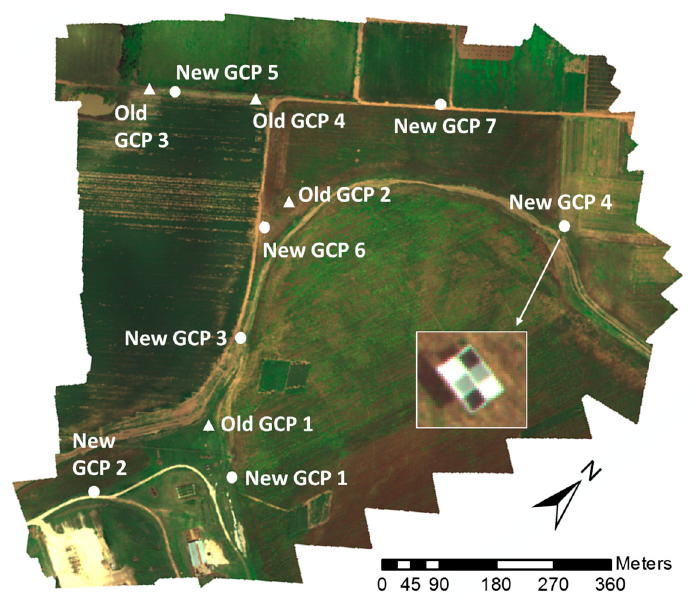
Figure 7. Distribution of all GCPs in the experiment field at Texas A&M AgriLife Research farm.